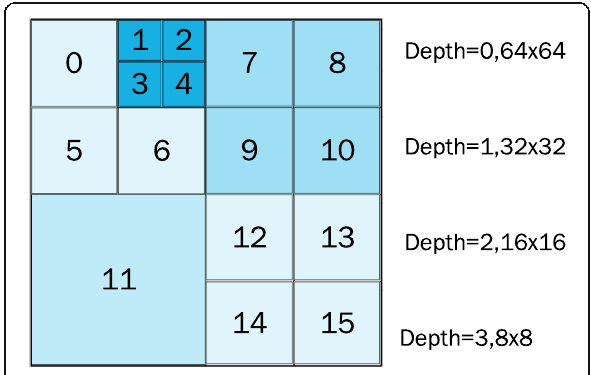
Fig. 5 Partition of a CU structure (64 × 64): quad-tree-based coding